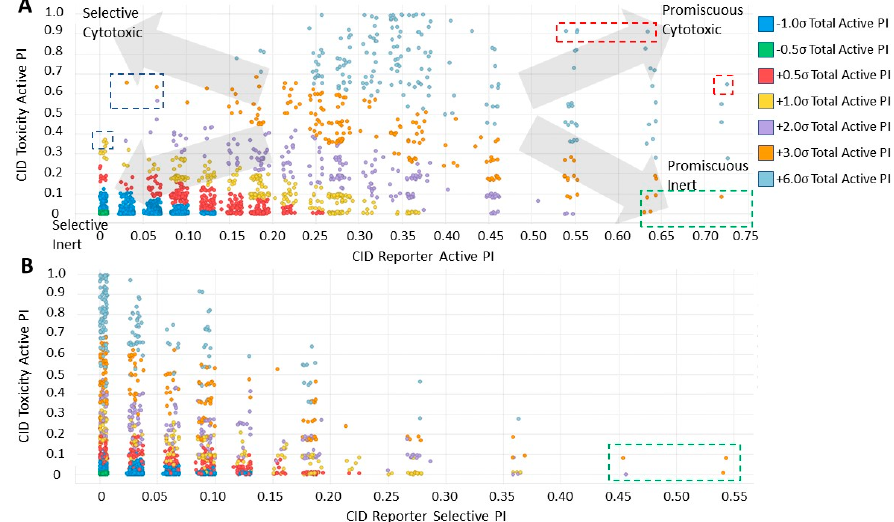
Figure 3. Promiscuity-based classification of individual compounds. ( A ) Reporter activity PI relative to toxicity activity PIs classifies compounds into groups of selective versus promiscuous (measured by relative reporter activity PI) and inert versus cytotoxic (measured by relative toxicity activity PI). Selected members of the selective cytotoxic (blue boxes), promiscuous cytotoxic (red boxes), and promiscuous inert (green box) groups were examined in more depth (Table 2). ( B ) Reporter selective PIs plotted relative to toxicity activity PIs. Examples of CIDs with high reporter selective PIs and low toxicity PIs (green box) were examined in-depth (Table 2). Data points are colored by total activity PI z-scores indicative of general promiscuity and were jittered on x- and y-axes for clarity due to non-continuous values of the PI values. Table 2. Examples of Promiscuous Compounds.